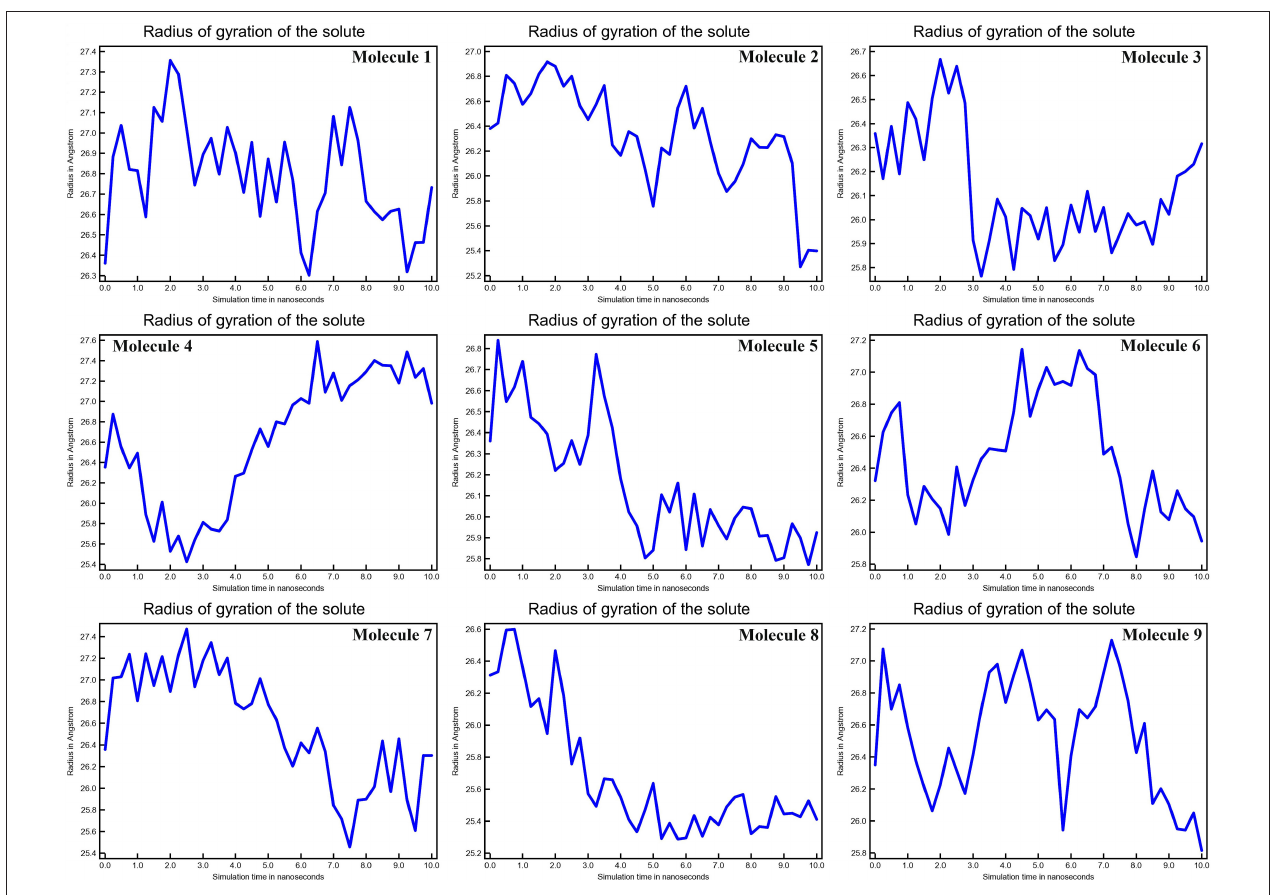
FIGURE 6 | Calculations of Radius of gyration of the solute of CYP51 and nine molecules as a function of 10 ns simulation time.